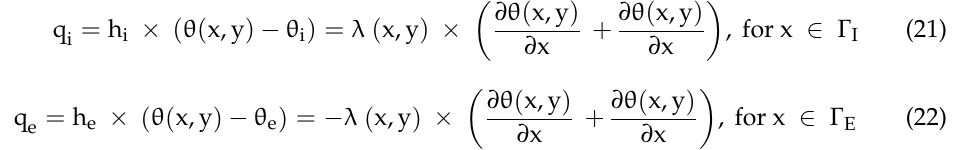
Figure 8. Model of a fragment of a structure with a generated mesh.